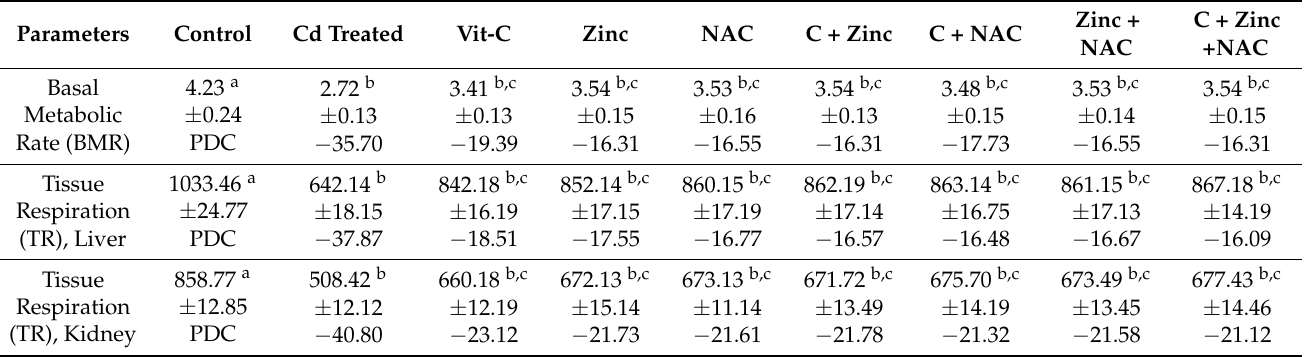
Table 2. Basal Metabolic Rate (BMR) and Tissue Respiration in Selected tissues in Control and Experimental rats.